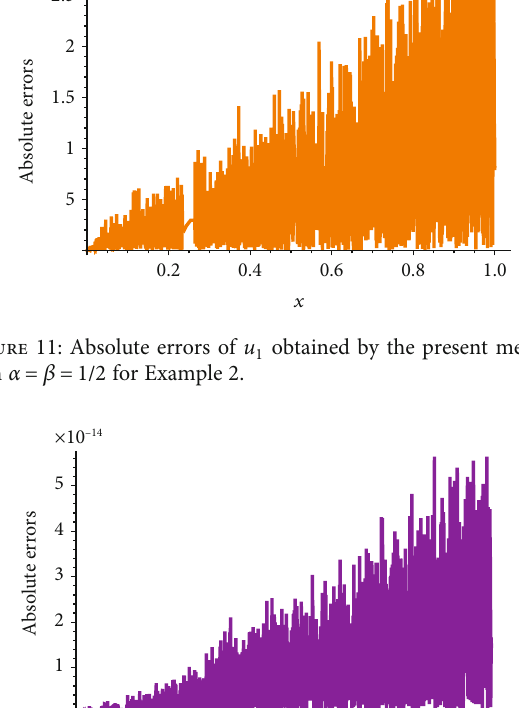
Table 3: The numerical solutions of u